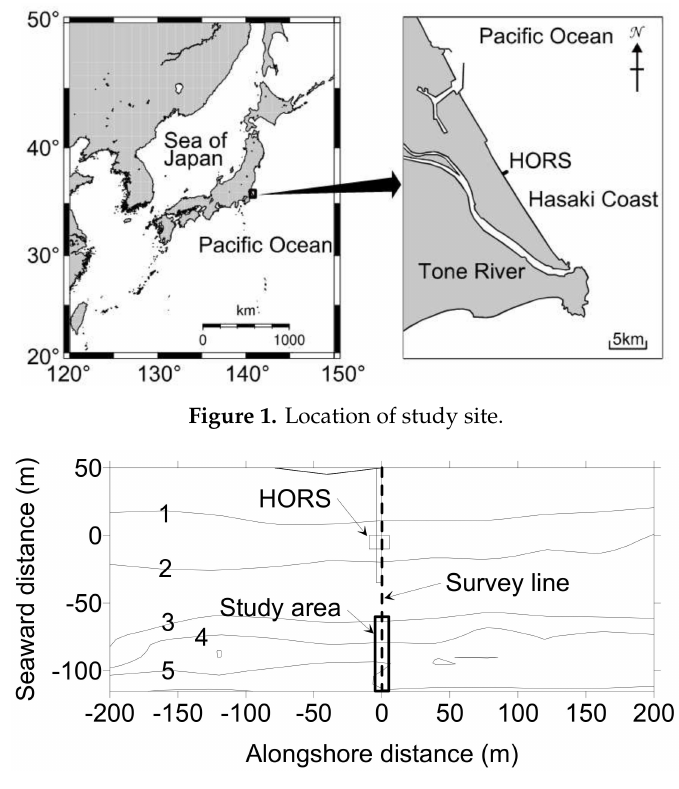
Figure 2. Plan view of the study area and the survey line. The contour lines are based on the survey data on 11 November